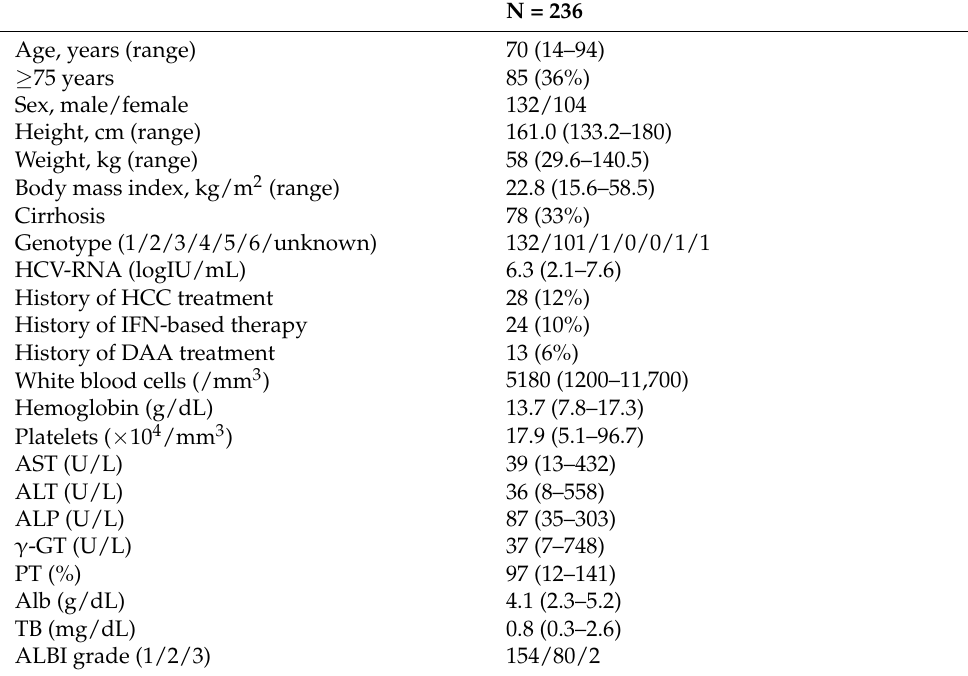
Table 1. Baseline characteristics of